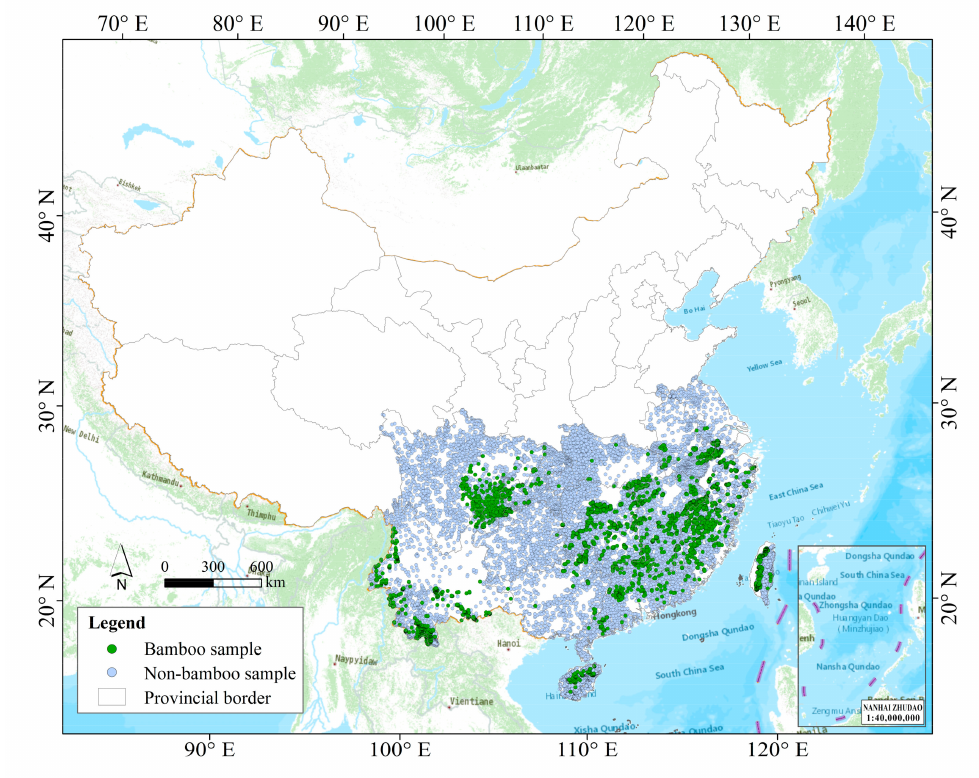
Figure 3. Spatial distribution of the bamboo and non-bamboo samples that we used in this